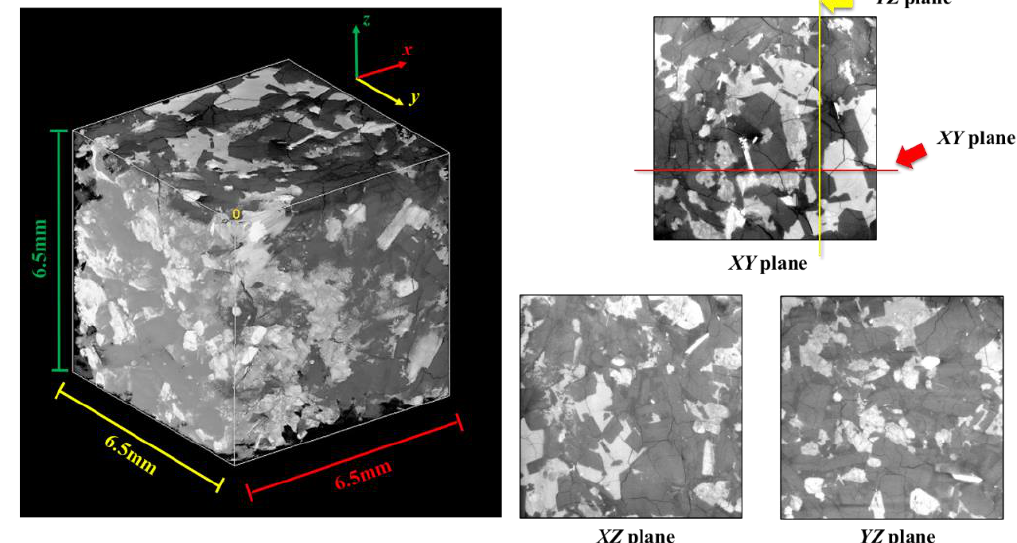
Figure 3. Three-dimensional reconstructed norite and its orthogonal slices.